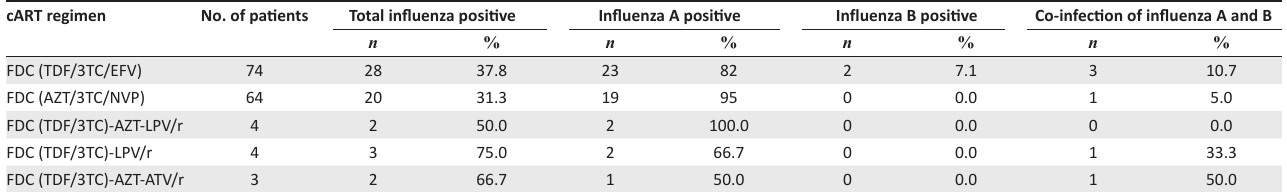
TABLE 2 : Commonly prescribed combined antiretroviral therapy regimens in HIV patients positive for influenza virus immunoglobulin M antibodies in 2018 in a university-based HIV clinic in Lagos, Nigeria. cART